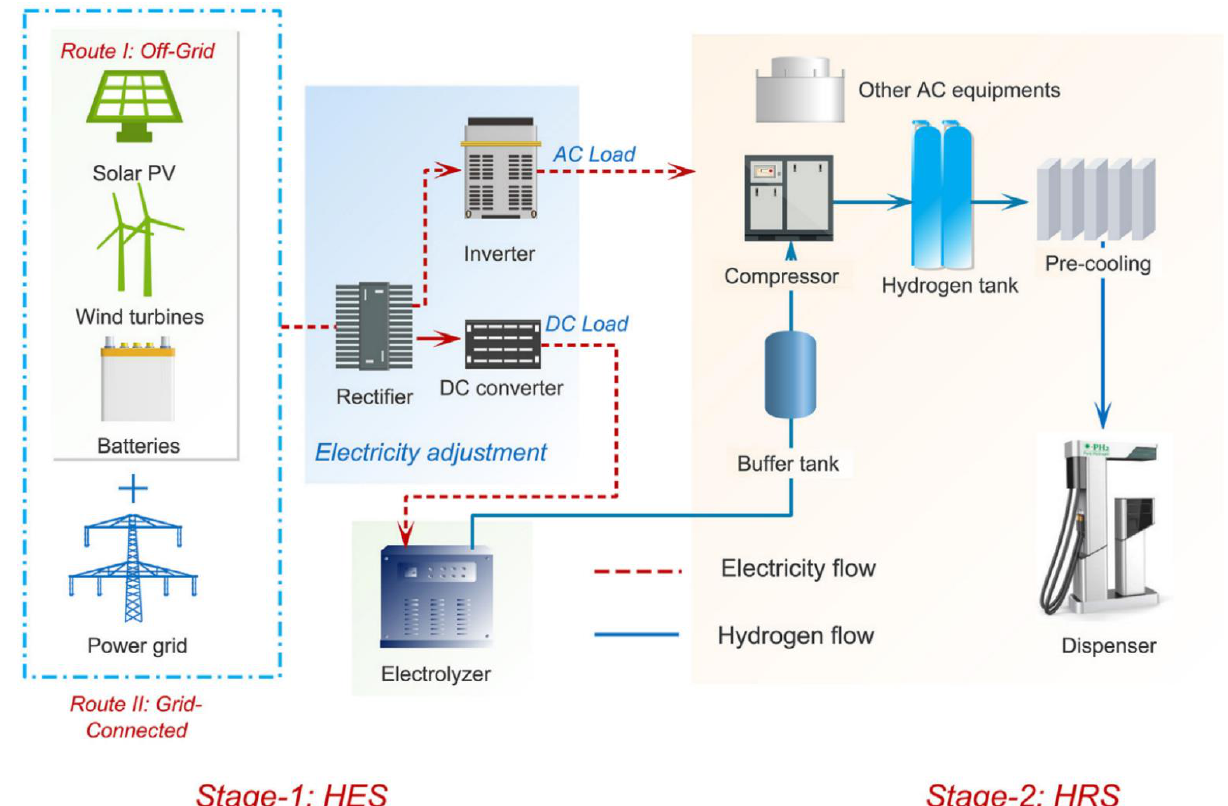
Figure 6. Schematic representation of a microgrid with onsite hydrogen refueling stations.